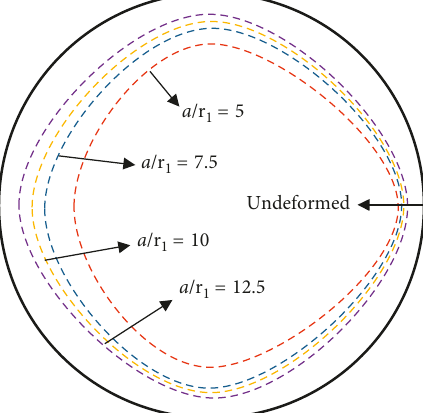
Figure 10: Adjacent empty hole deformation diagram with dif- ferent hole